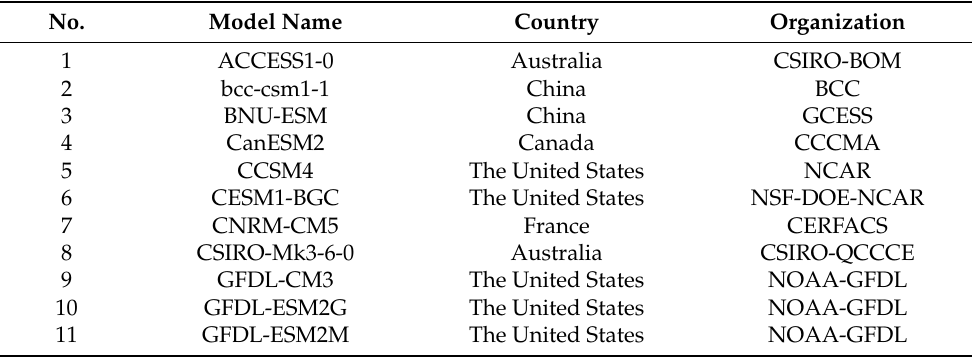
Table 1. Information for the 21 CMIP5 global climate models in NEX-GDDP dataset.